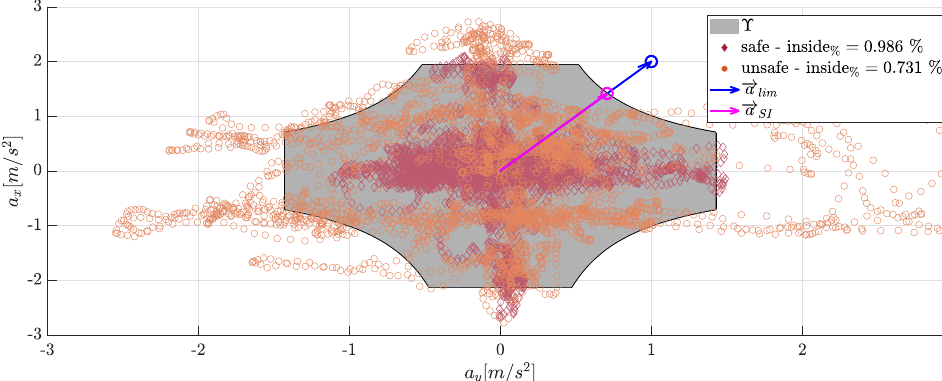
Figure 6. Experimentally identified safe region, for the deck IMU.